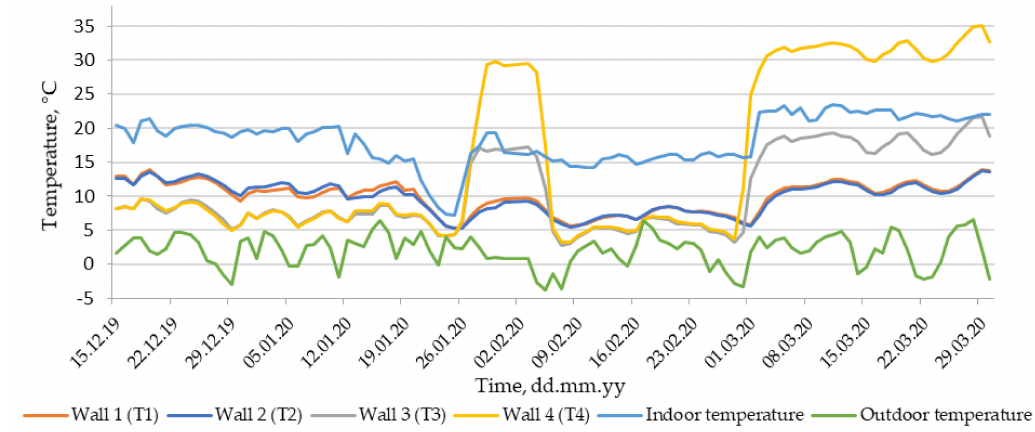
Figure 6. Test wall temperatures. Reproduced with permission from [11].